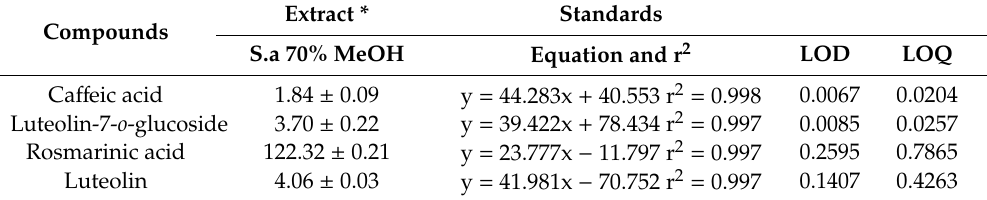
Table 5. HPLC results of S. aramiensis extract.